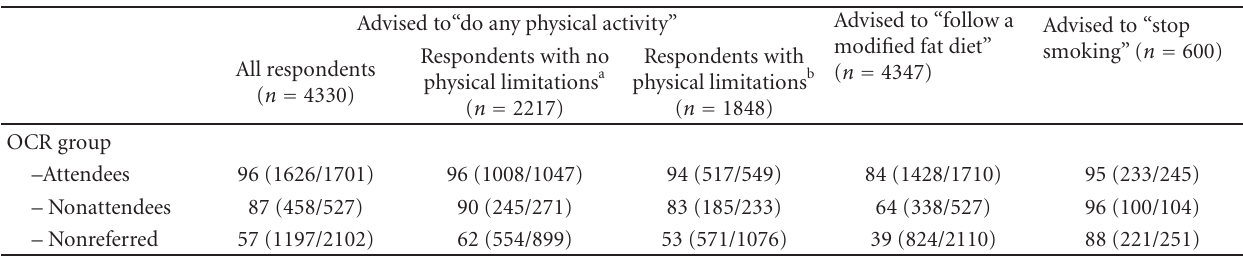
Table 2: Self-reported receipt of lifestyle advice from a healthcare provider stratified by participation in outpatient cardiac